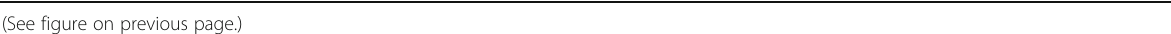
node and the ascending aorta. d Ultrasound color Doppler image shows Echo Tip ProCore HD 22G needle (N) passing through enlarged lower paratracheal lymph node (4R), right pulmonary artery (RPA), and S.V.C. e Ultrasound color Doppler image shows Echo Tip Ultra HD 22G needle passing through enlarged right lower paratracheal lymph node (4R), RPA, and S.V.C. f Echo Tip Ultra HD 22G EBUS-TBNA needle sample shows adenocarcinoma (black arrow) (H&E, × 400). g Echo Tip ProCore HD 22G EBUS-TBNA needle sample shows adenocarcinoma (black